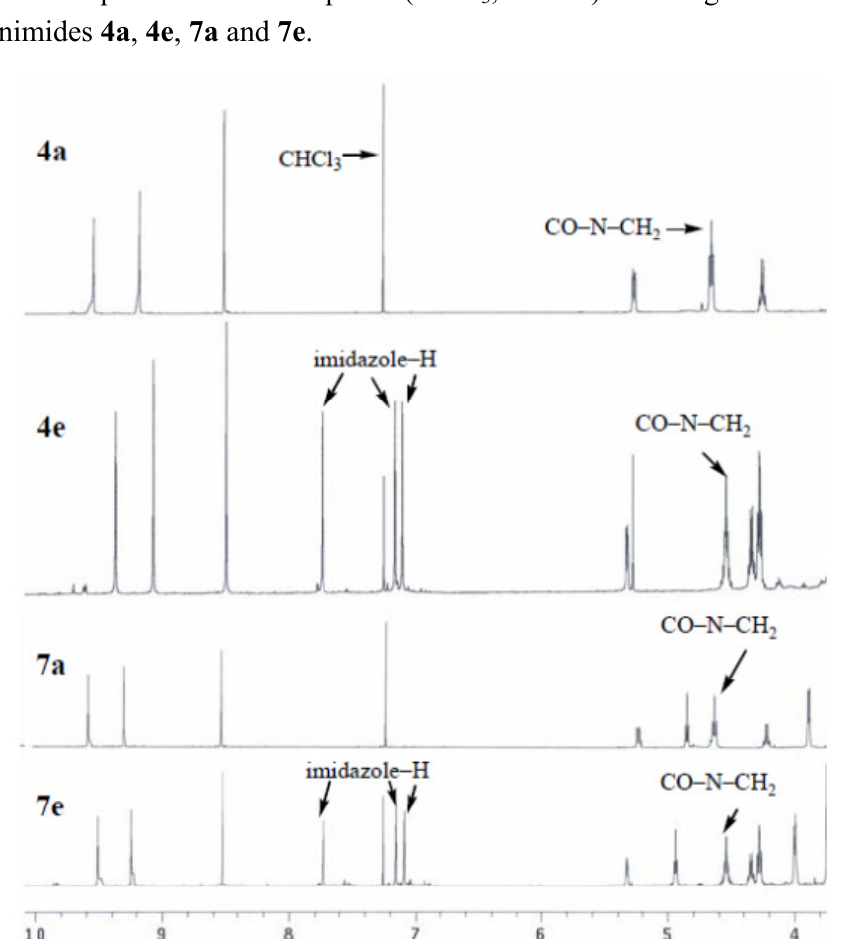
, 500 Hz) in the region of δ 4.0–10.0 ppm 3